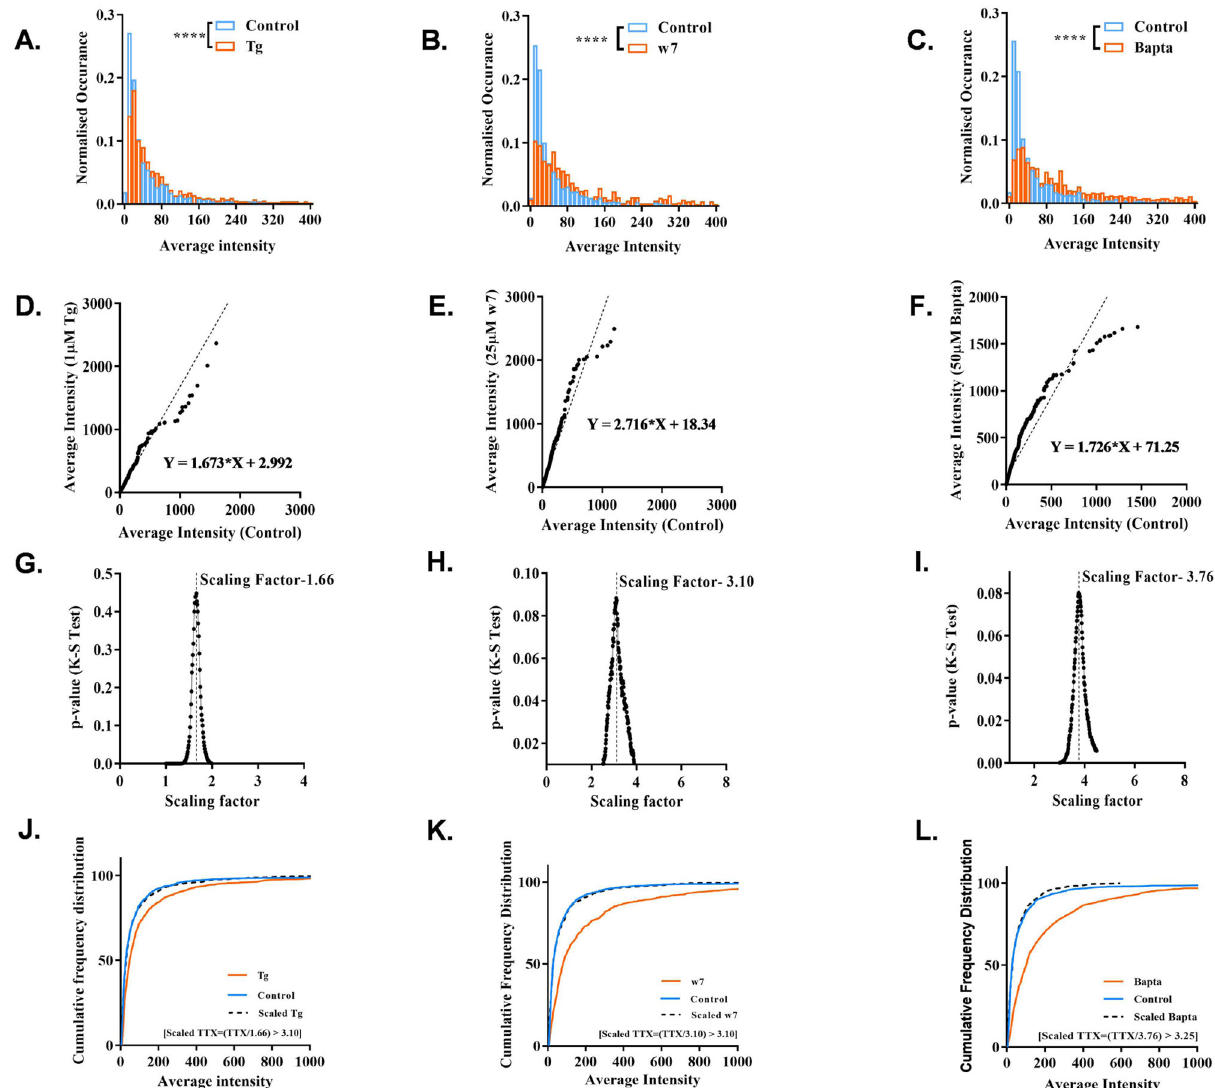
Fig. 3 Scaling of endogenous SAP97 clusters using rank-order analysis. A – C The histogram was plotted for the average intensity of SAP97/hDLG clusters between control and all treated conditions. A Thapsigargin (1 μ M), B w7 (25 μ M), and C Bapta (50 μ M). N = 10 cells for control and treated datasets. D – F A total of 1000 cluster datapoints of average intensity were chosen randomly from each dataset, rank-ordered, and plotted to provide a linear regression for each condition. The slope of regression depicts an arbitrary scaling factor. G – I The analysis provided a scaling factor with a maximum p -value between control and scaled-treated datasets. The p -values for Tg ( D ), w7 ( E ), and Bapta ( F ) were p = 0.44, p = 0.09, and p = 0.08, respectively. A total of 800 – 1000 random average intensity datapoints were chosen from each dataset, rank-ordered, and plotted to provide a linear equation for each treatment. J – L A cumulative frequency distribution was plotted for control, treated, and scaled-treated conditions of SAP97/hDLG in Neuro-2a cells. The datasets were analyzed for a signi fi cant change in mean values by two-tailed K – S test, * p < 0.05, ** p < 0.01, **** p < 0.0001 (Supplementary Table